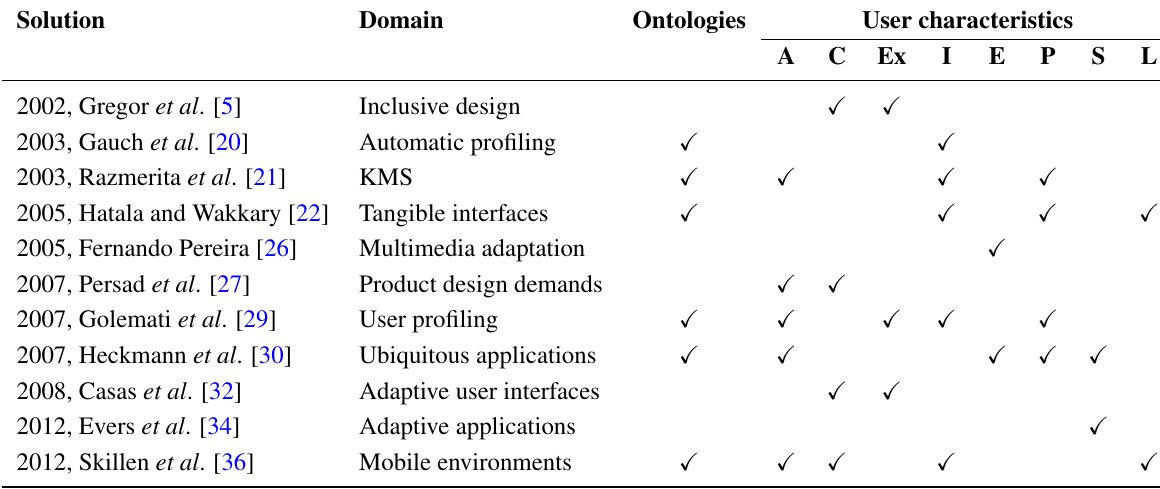
Table 1. Related work for the user modeling approaches. Under the user characteristics heading A ctivities or behavior, Capabilities, Experience, Interests, Emotions, Personal, Stress and Location information are